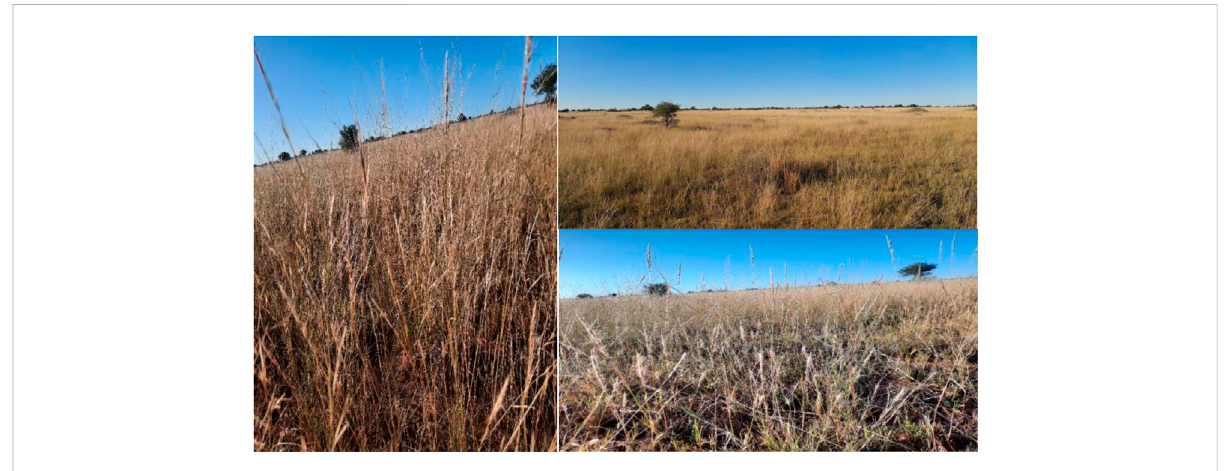
FIGURE 3 Aristida species, less palatable grass species. Photo taken by H. S. and K.